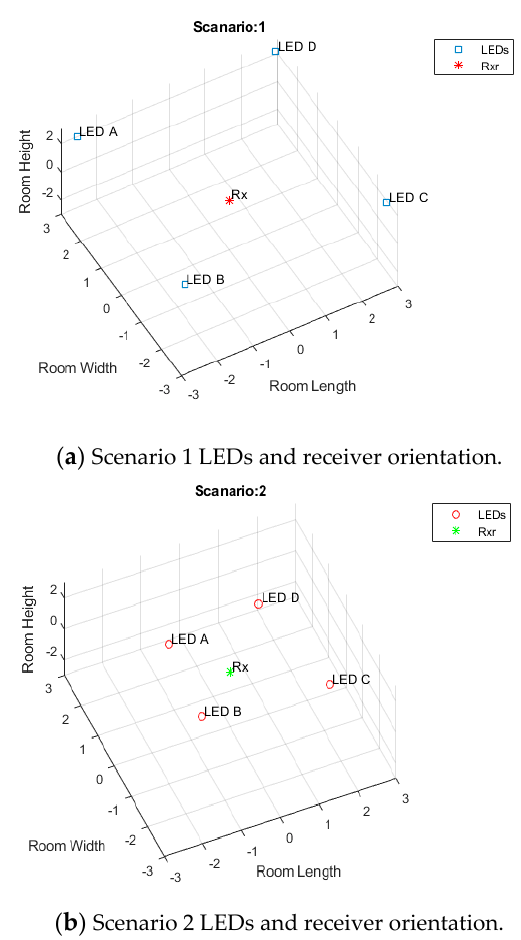
Figure 4. Different orientations of transmitters and receivers for different scenarios. Figure 4. Di ff erent orientations of transmitters and receivers for di ff erent scenarios.